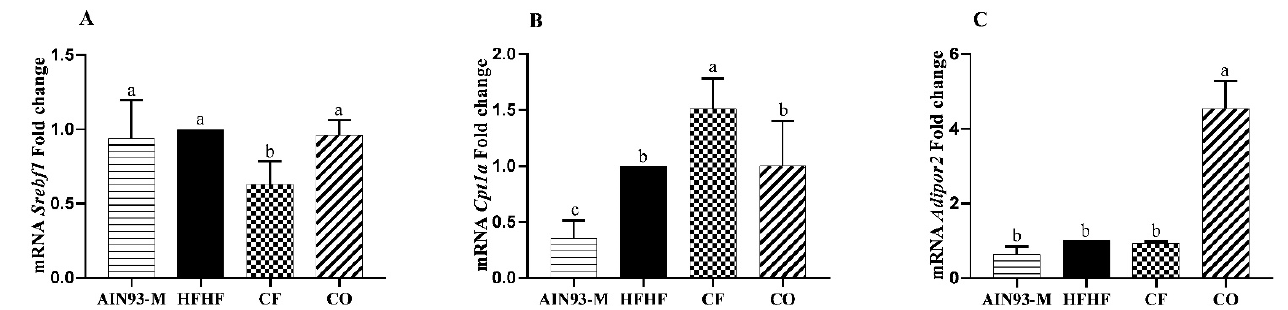
Figure 4. ( A ) Srebf1: sterol regulatory element-binding transcription factor 1; ( B ) Cpt1a: